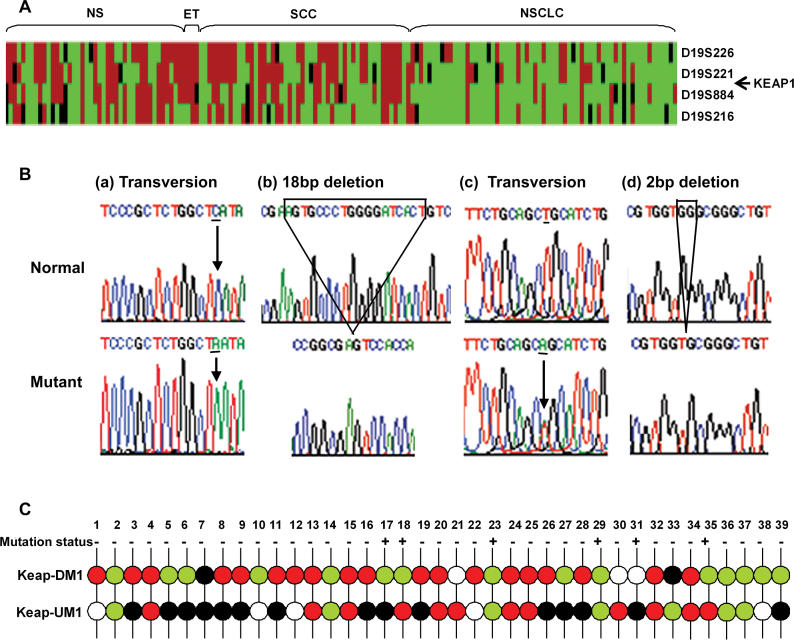
Somatic Alterations in KEAP1 in Lung Cancer(A) LOH at the 19p13.1–13.3 region. A heat map depicts microsatellite-based LOH at 19p13.1–19p13.3 in 181 lung cancer cell lines. Tumor-derived cell lines that were non-informative for this region were not included. Microsatellite markers showing heterozygous typings are depicted in red, markers demonstrating homozygous typing are in green, and non-informative markers in black. Each vertical column represents one cell line. ET, endocrine tumors; NS, no subtype specified; SCC, small cell carcinoma.(B) Sequence analysis of KEAP1 mutations in lung cancer. Part a shows the H838 cell line showing C–A substitution (G–T, plus strand), resulting in a termination codon. Wild-type sequence is from BEAS2B. A wild-type allele was not detected in H838. Part b shows a 18-bp deletion in one allele but not in the other allele in the PF DNA sample from PF-8. Part c shows tumor PT-23, showing A–T substitution in one allele but not in the other allele. Part d shows a 2-bp deletion in the fourth exon of KEAP1 that was detected in one allele of PT-17. Samples showing deletion mutations were confirmed by subcloning and sequencing.(C) LOH at the KEAP1 locus in human primary lung tumors. Summary of LOH patterns of 39 NSCLC tumors. Retained microsatellites are indicated in red, markers demonstrating allelic loss in green, markers showing genomic instability in white, and non-informative markers in black. KEAP-UM1 (CA17) is present upstream of the KEAP1 locus, and KEAP-DM1 (CA21) is present downstream of the KEAP1 locus.